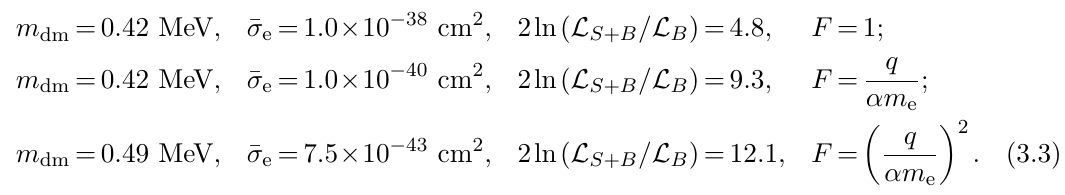
figure 2, for the three form factors adopted here. The best-fit model parameters and (logarithmic) likelihood ratios